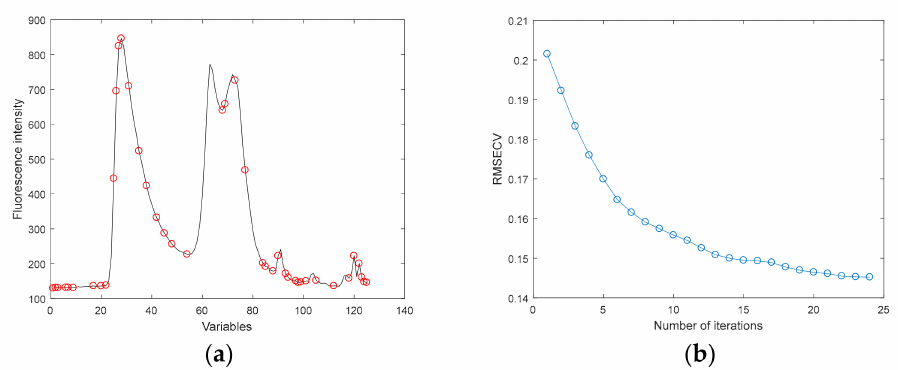
Figure 9. The extraction process of VISSA: ( a ) distribution of effective variables; ( b ) the curve of RMSECV .